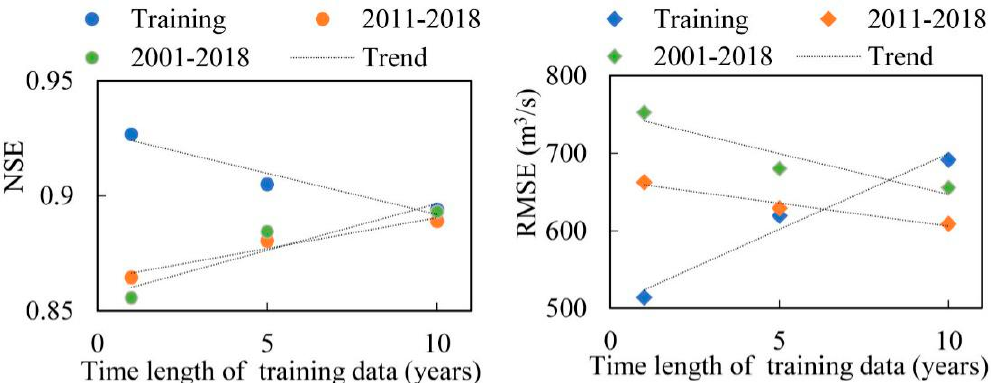
Figure 9. Variations in NSE and RMSE for daily discharge estimates at Nuxia station with changing duration of the precipitation training data time series. The Y axis is the average NSE or RMSE of daily discharge estimates for all combinations using the same duration of training data (see Table 2). The precipitation data are from the TRMM